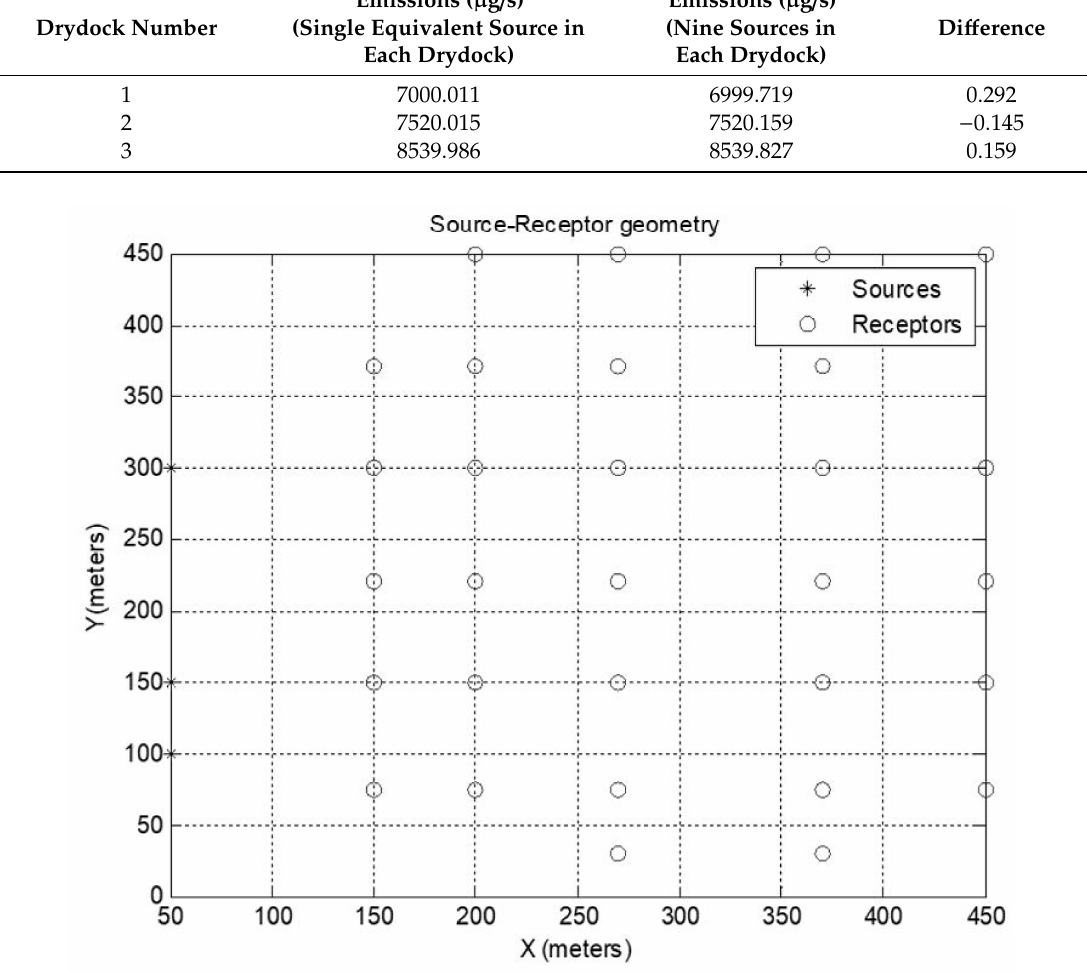
Figure 7. New source-receptor grid with the three